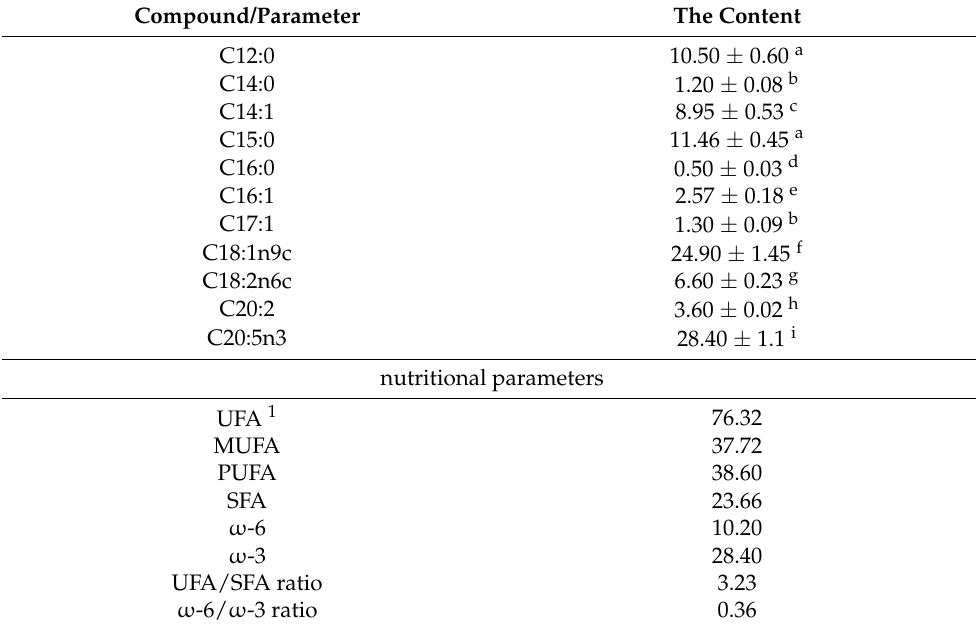
Table 3. Fatty acid content (% of total fatty acids expressed in dry weight) in bee-collected artichoke pollen with nutritional